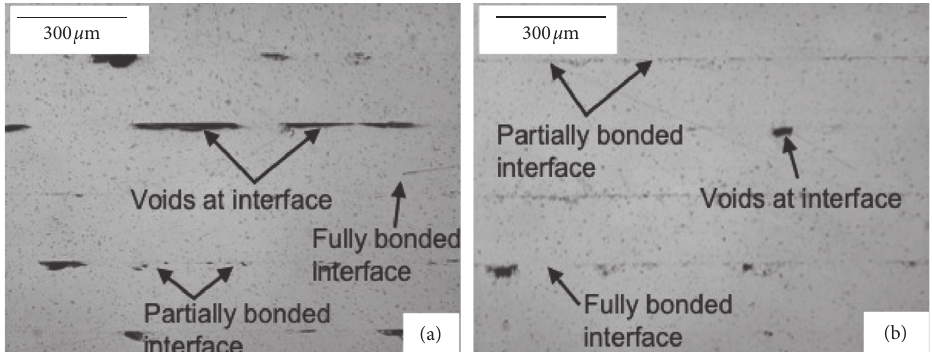
Figure 6: Macrographs of Al3003 build showing voids at the interface